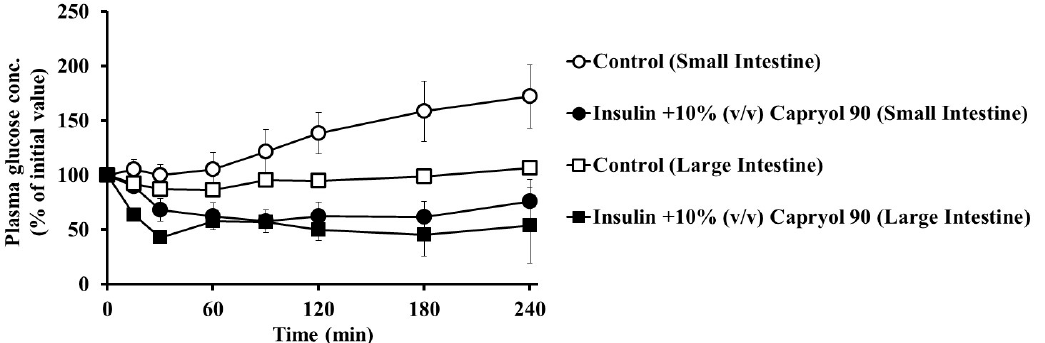
Figure 4. Regional difference in the effect of Capryol 90 on the intestinal absorption of insulin using an in situ closed loop. Insulin absorption following an 80 IU/kg dose was estimated by measuring plasma glucose levels. Each value represents the mean ± S.E. ( n = 3).